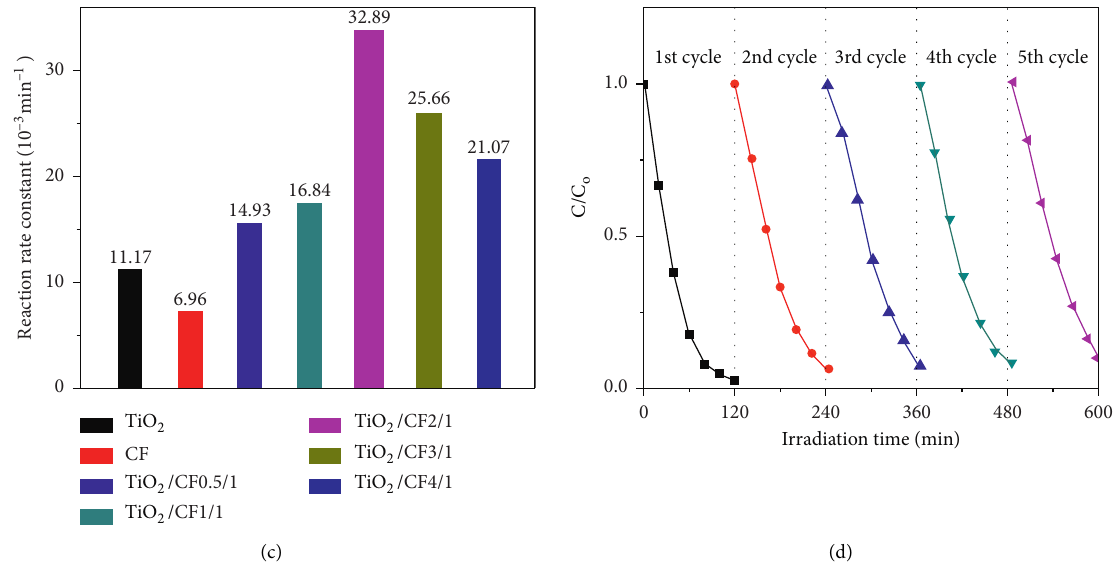
Figure 10: (a) The photocatalytic degradation rate of MB when TiO 2 powder, CF, and the prepared TiO 2 /CF composites were irradiated under UV light for 2h; (b) kinetic curves of photocatalytic degradation of TiO 2 powder, CF, and the prepared TiO 2 /CF composites; (c) reaction rate constants of TiO 2 powder, CF and the prepared TiO 2 /CF composites; (d) study on the stability of TiO 2 /CF2/1 photocatalytic degradation